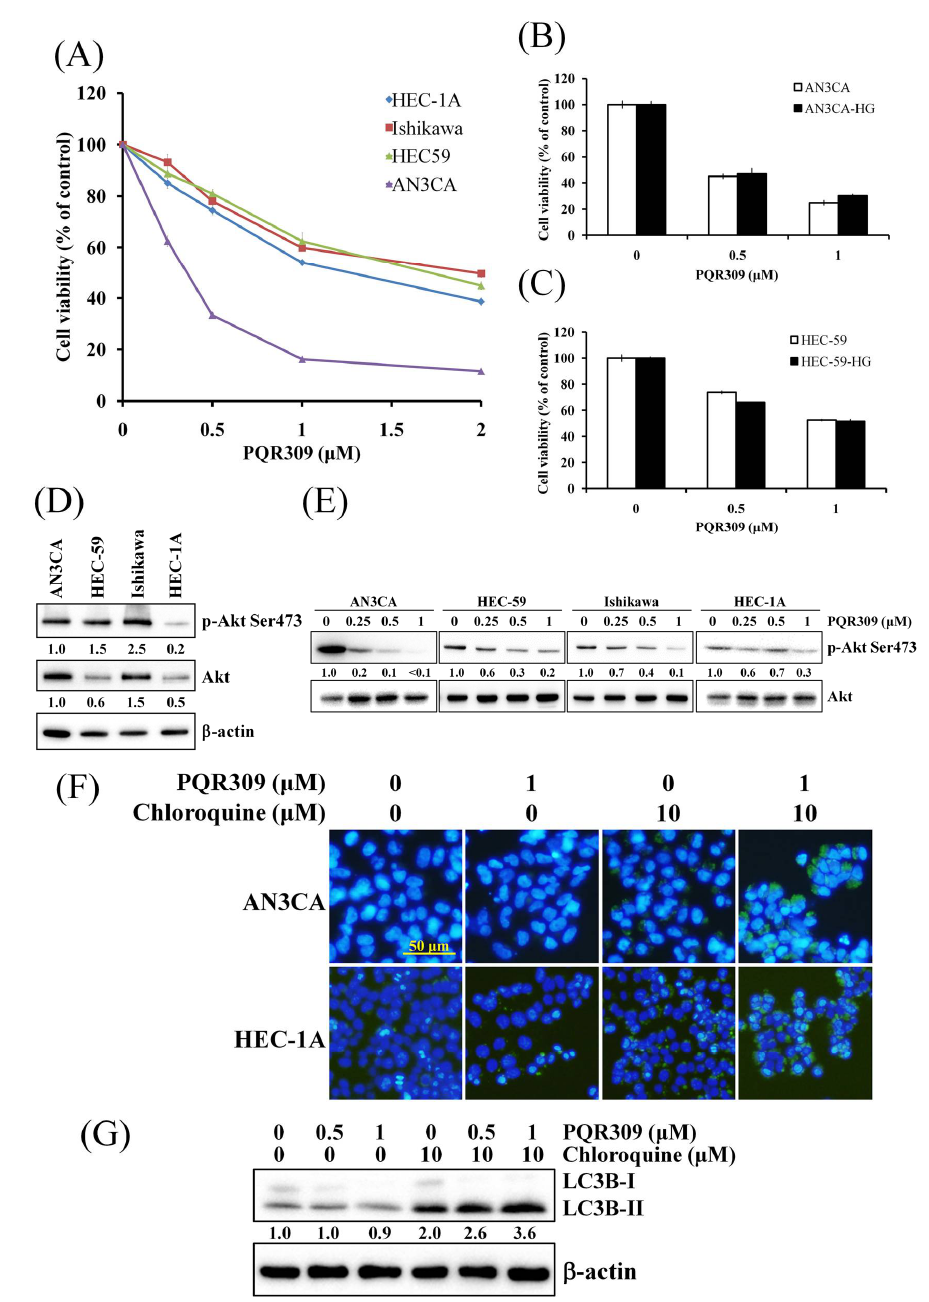
Figure 1. Effect of PQR309 on cell viability and autophagy induction in endometrial cancer cells. ( A ) AN3CA (5 × 10 3 cells/well of 96-well plate), HEC-59 (6 × 10 3 cells/well of 96-well plate), Ishikawa (6 × 10 3 cells/well of 96-well plate), and HEC-1A (6 × 10 3 cells/well of 96-well plate) were treated with various concentrations of PQR309 (0, 0.25, 0.5, 1, and 2 μM) for 72 h. Cell viability was analyzed by MTT assay. ( B , C ) After PQR309 (0, 0.5, and 1 μM) treatment for 72 h in indicated cells, cell viability was analyzed by MTT assay. HG, high-glucose medium culture. ( D ) Protein expressions of p-Akt, Akt, and β-actin were determined by Western blot. ImageJ software was used to quantify the band intensities of p-Akt and Akt. Data shown are the relative expression standardized by the β-actin protein level. The ratio of AN3CA was set at 1. ( E ) After PQR309 (0, 0.25, 0.5, and 1 μM) treatment for 48 h in indicated cells, equal amounts of total cell lysates were an- alyzed by Western blot assay. β-actin served as a loading control. ImageJ software was used to quantify the band inten- sities of p-Akt. Data shown are the relative expression standardized by the Akt protein level. The ratio of cells without